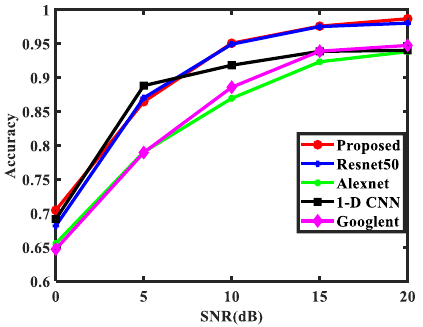
Figure 10. The classification performance for different methods. Table 6. The performance evaluation based on F1